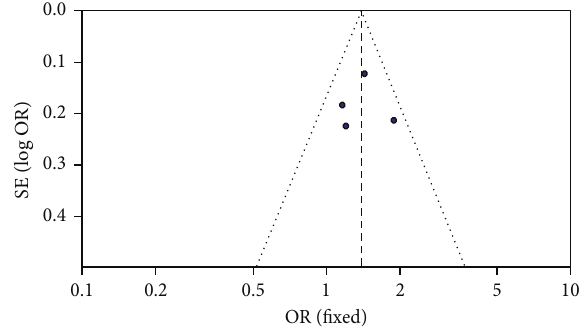
Figure 3: Funnel plot for studies of AF associated with Mink S38G gene polymorphism under an allelic genetic model (distribution of G allelic frequency of Mink S38G gene polymorphism) after sensitivity analysis in the Chinese population. The horizontal and vertical axis correspond to the OR and confidence limits. OR: odds ratio; SE: standard